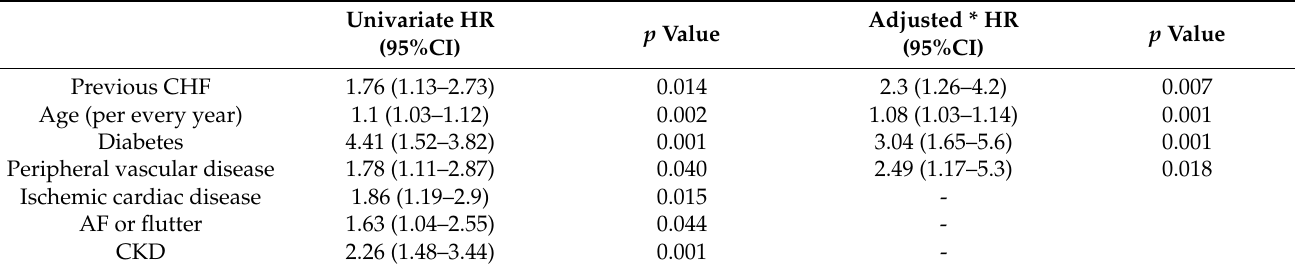
Table 4. Hazard ratios of 30-day death for previous CHF adjusted for potential